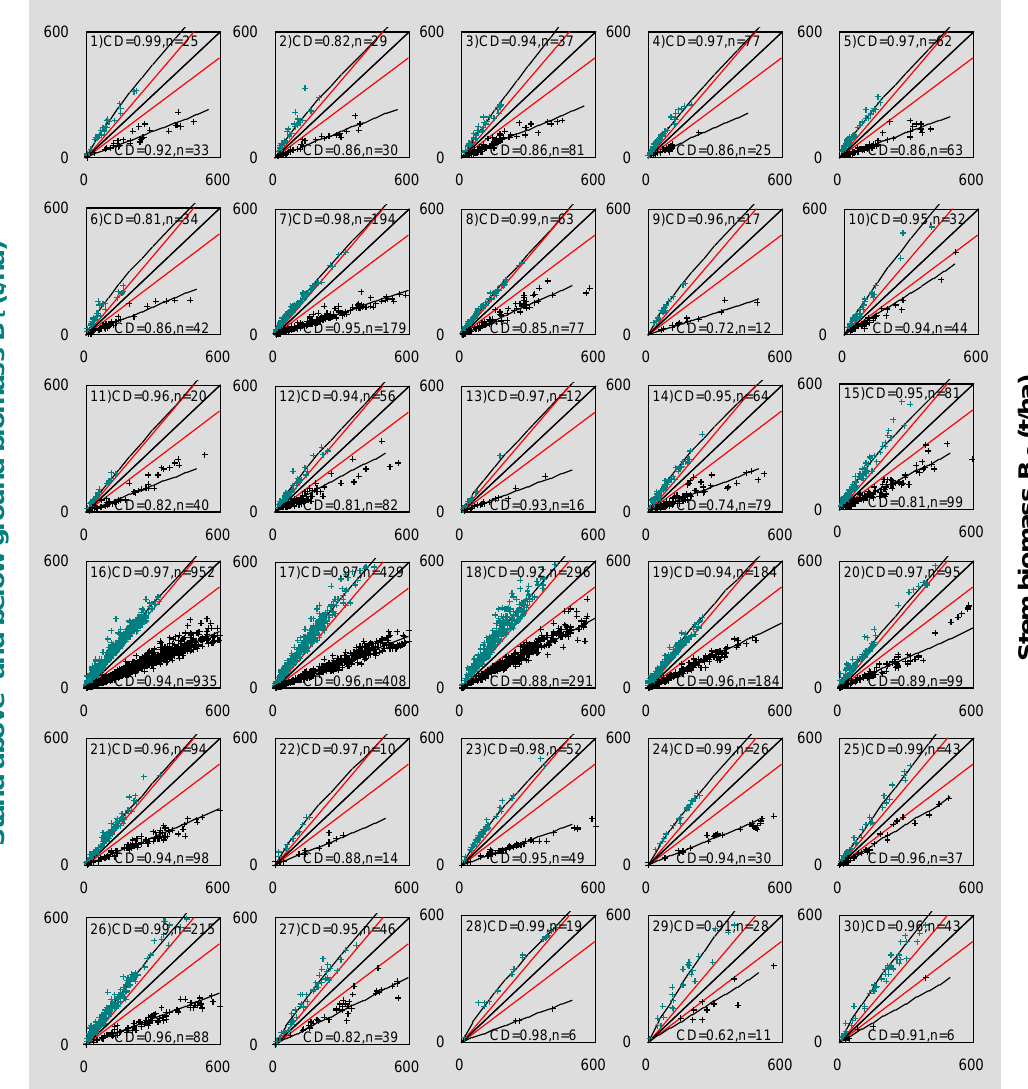
Figure 4. The correlation scatters of 30 tree species and forest types across the world. The least squares regression was performed for fitting V-to-B s equation. The nonlinear regressions were conducted for fitting relationships of B t and B s . The scatters show stem biomass vs. SABB (curves with cyan crosses in top left sections) and growing stock volume vs. biomass (straight-lines with black crosses in bottom right sections). The top left parts illustrate the regression for Equation (1), and bottom right parts do this for Equation (2). CD means coefficient of determination; n is the numbers of plots. Every scatter has two red lines that warn the lower limit for Equation (1) and the upper limit for Equation (2). Note that these red lines are set up tentatively for approximate estimates of the restricted zone that may change for different species and types. The number of each scatter corresponds to the number listed in Table 1. Three variables (volume, stem, and SABB) were measured for most plots. The samples of B s vs. B t are less than the ones of V vs. B s , because some plots were not measured for roots or volumes. For the data details refer to the footnotes of Table 1.